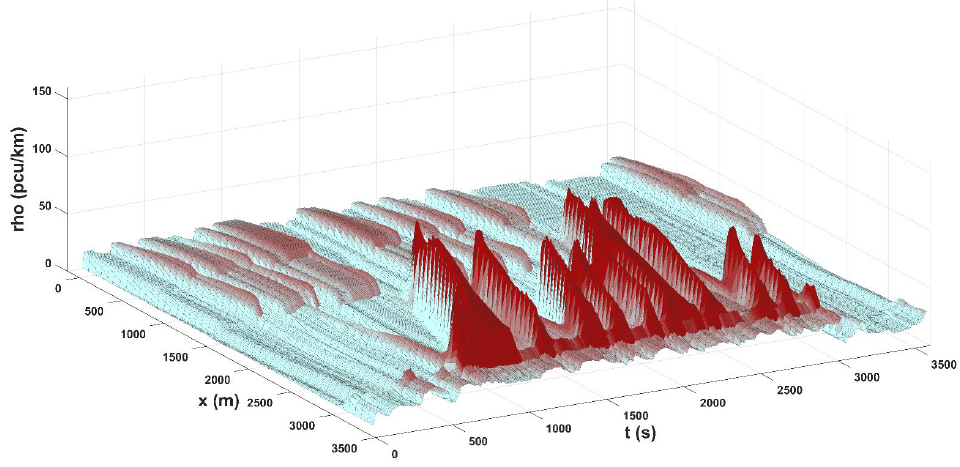
Figure 3. Density in time and space in scenario 1.